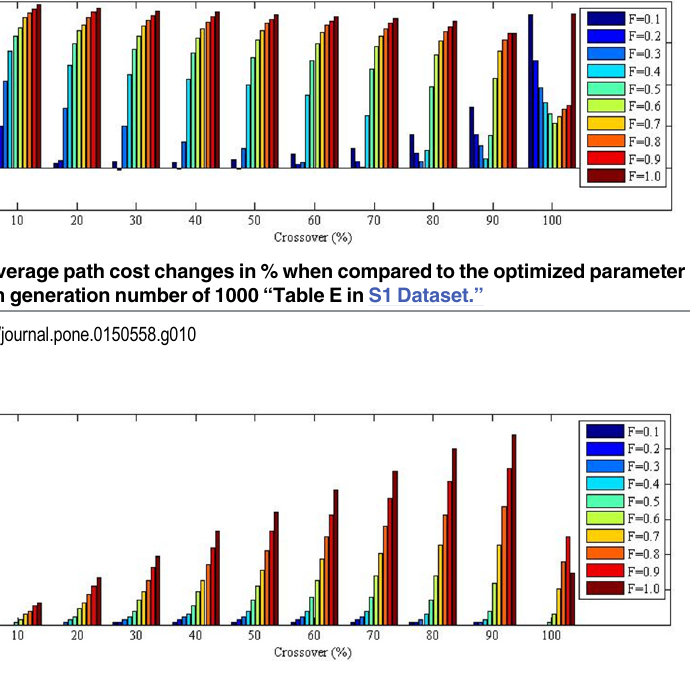
Fig 11. Average computational cost changes in % when compared to the optimized parameter setting at maximum generation number of 1000 “ Table F in S1 Dataset.